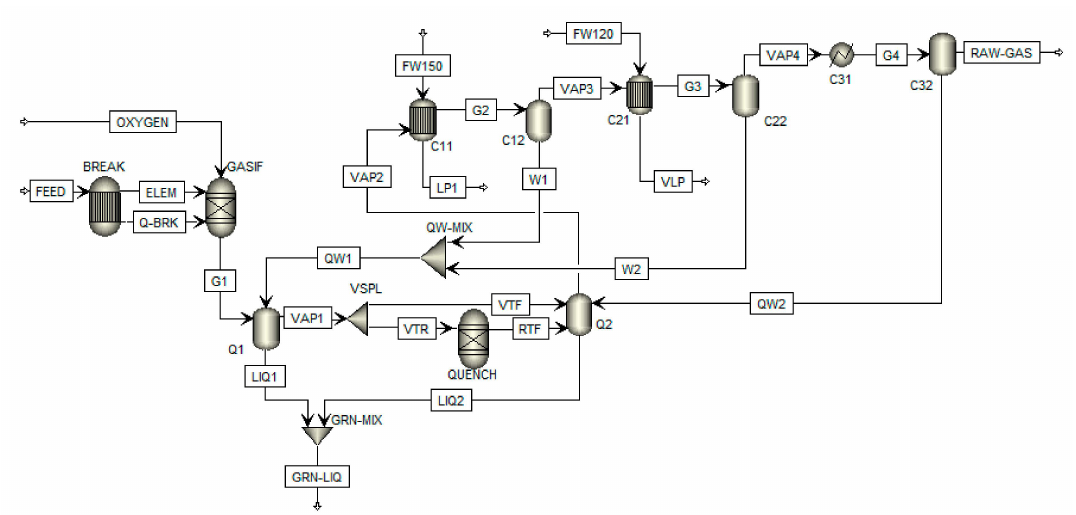
Figure 2. Scheme of black liquor gasification model in Aspen Plus software.